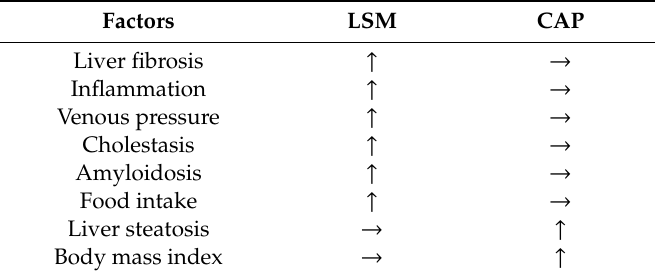
Table 4. Associations between factors a ff ecting the LSM or CAP